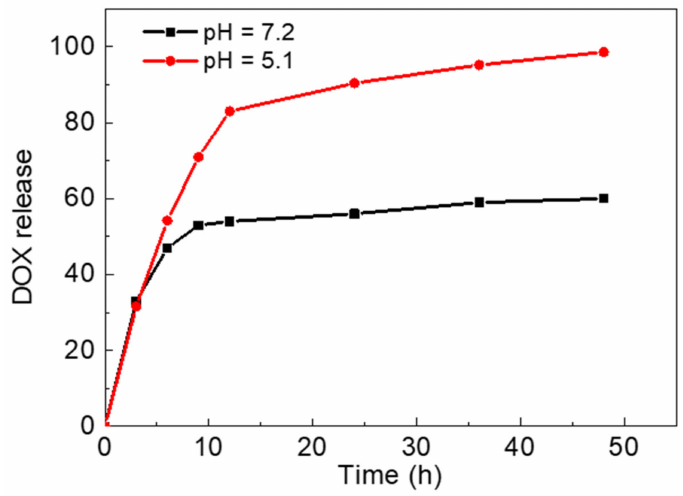
Figure 3. Release rate of DOX in buffer at pH = 5.1 and pH =